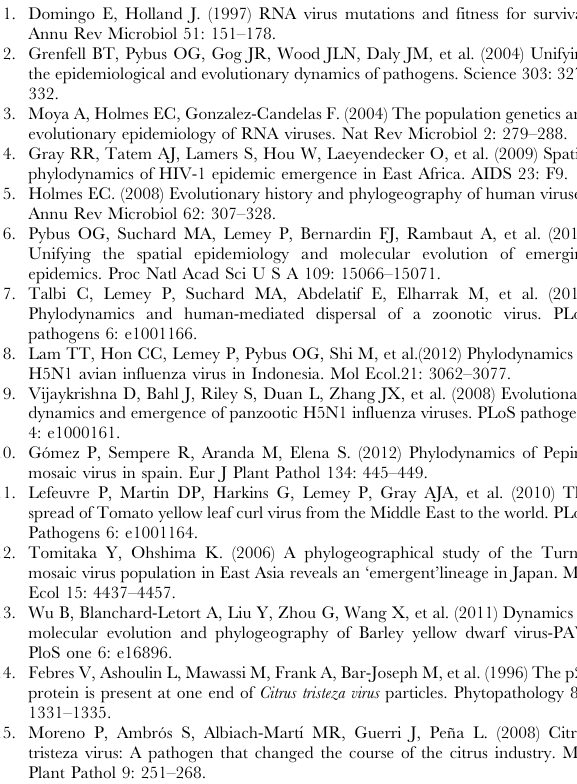
location-annotated MCC was converted with SPREAD [57]. The branches are colored according to the node height values with red specified as the maximal and black as the minimal boundary.